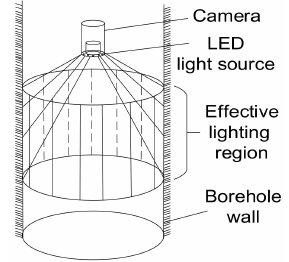
Figure 12. Schematic drawing of an axial view camera.